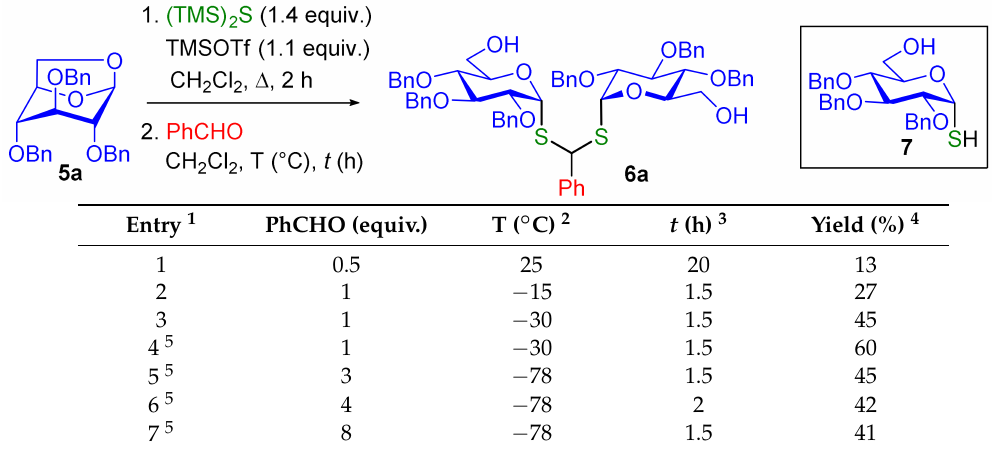
Table 1. Optimization of the one-pot thioacetalization